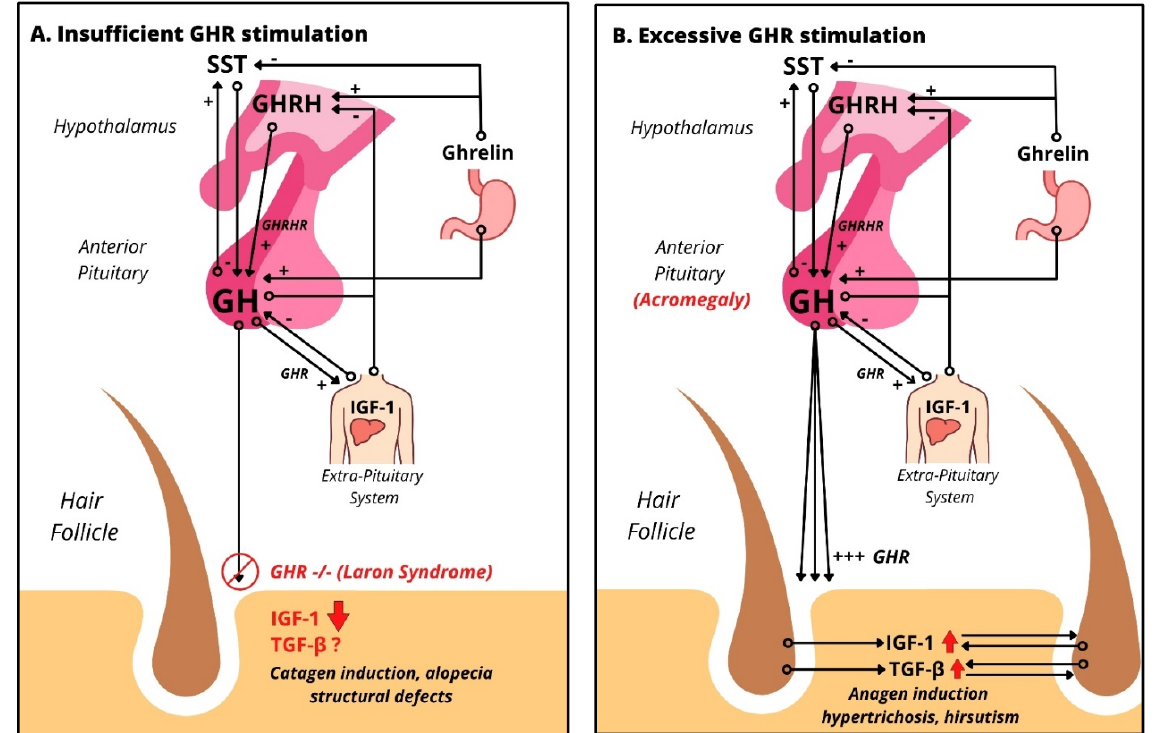
Figure 2. Impact of excessive and insufficient GHR stimulation on human scalp HFs: ( A ) HPS axis in the case of absent GH signaling, like Laron’s syndrome, leading to almost absent levels of IGF-1 due to absent GHR stimulation. Clinical findings include alopecia, frontal hairline recession, and structural defects. ( B ) HPS axis in the case of GH excess, like acromegaly, which upregulates both IGF-1, an anagen promoter, and TGF- β , a catagen promoter. Clinically, acromegaly patients show increased hair growth and